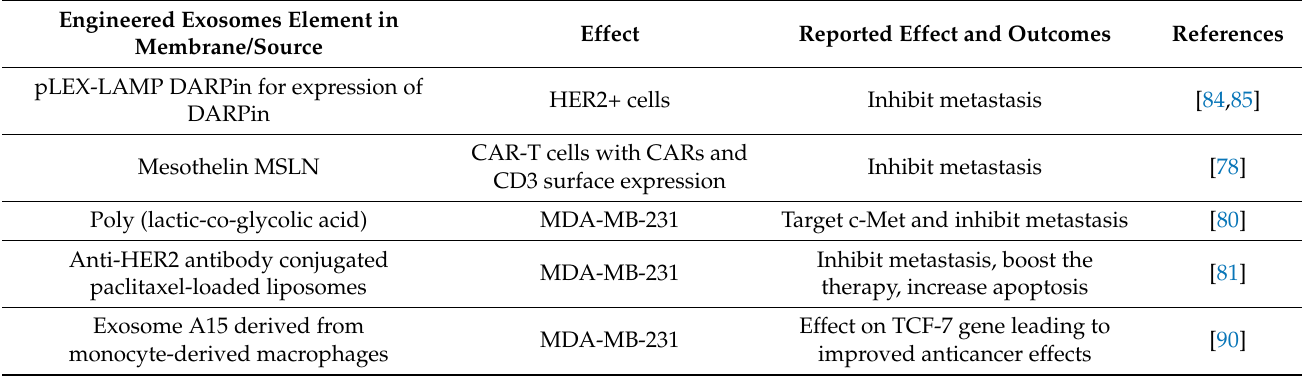
Table 1. Engineered exosomes with different proteins embedded their membranes, and their effects on triple-negative breast